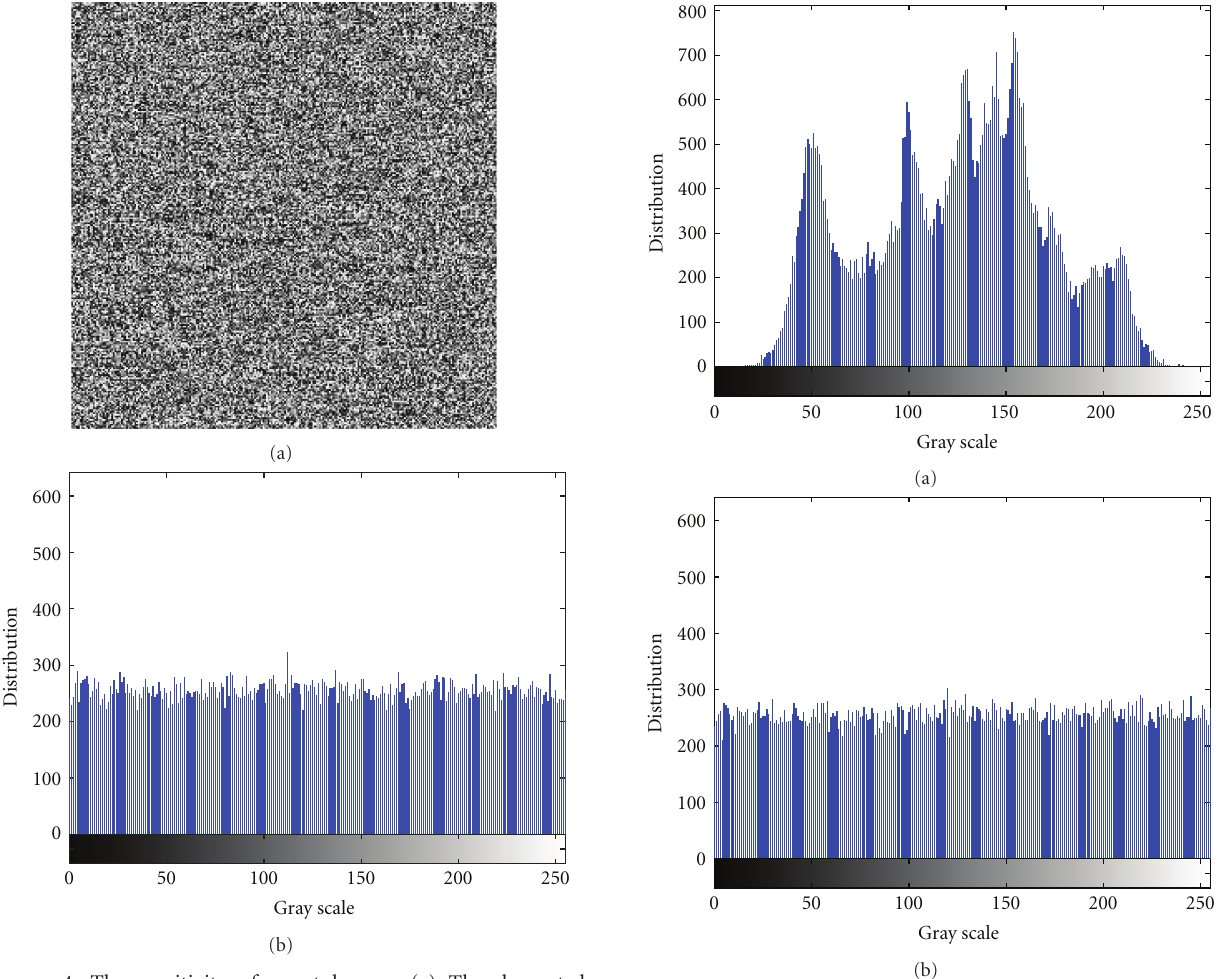
Figure 4: The sensitivity of secret key x 0 . (a) The decrypted image with secret key (0 . 95000000000001,3 . 2,0 . 17,0 . 25,3 . 3,0 . 14). (b) The corresponding histogram.